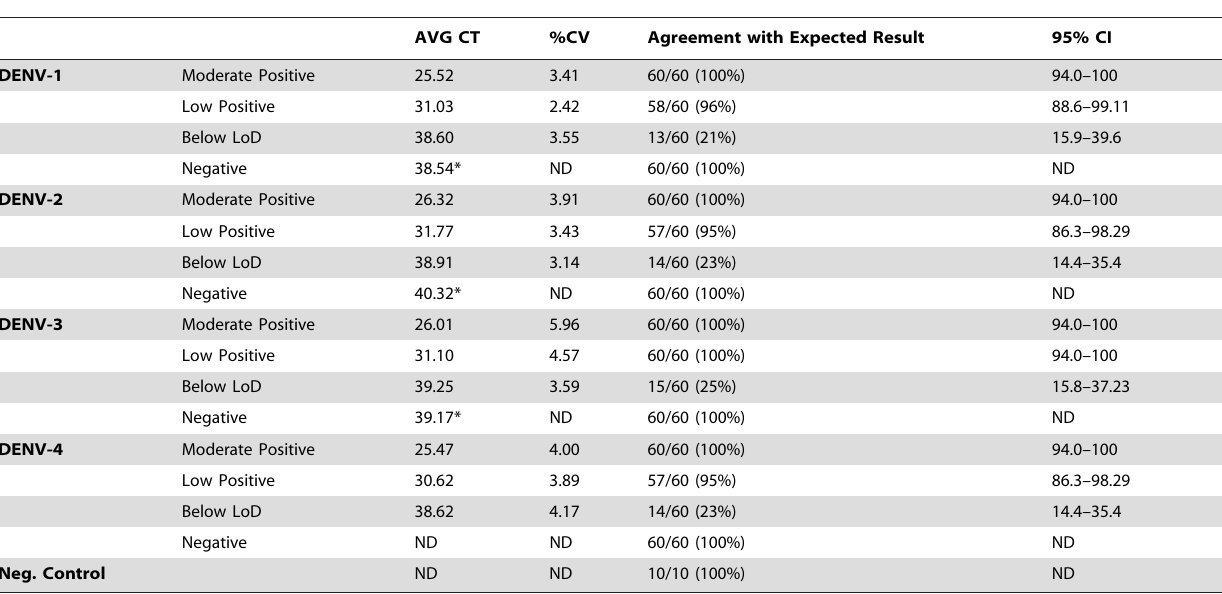
Table 6. Reproducibility summary for the CDC DENV-1–4 Real-Time RT-PCR Assay including results from three testing sites.